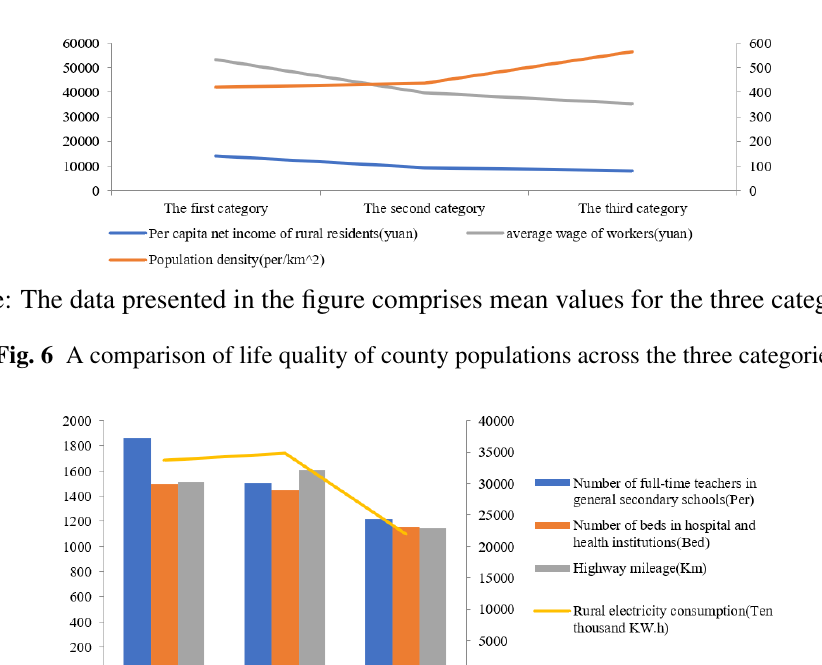
Fig. 7 A comparison of infrastructure for counties across the three